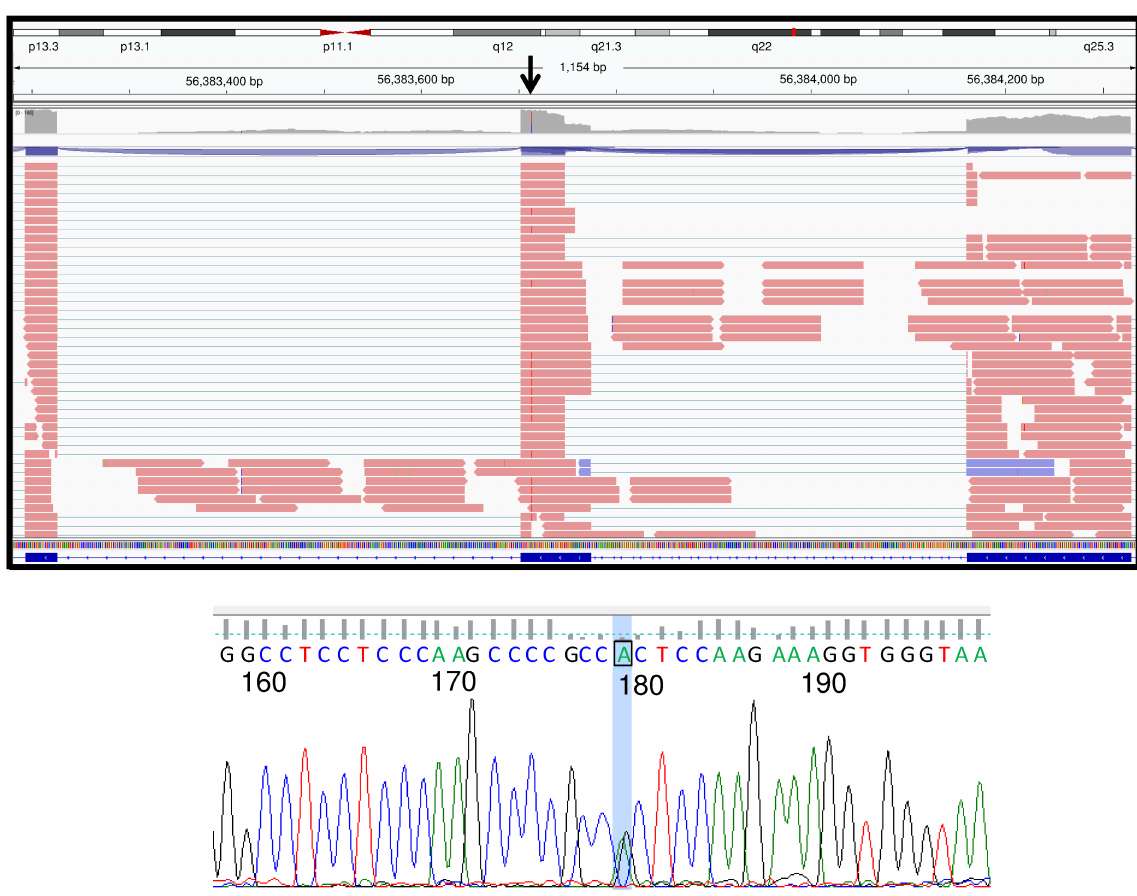
Fig 3. Identification of a rare TSPOAP1 variant in RNA142 (from patient 2011–395). RNASeq data (top panel) and a Sanger sequencing trace from patient 2011–395 DNA (bottom panel) are shown. Top panel image obtained from the Integrative Genomics